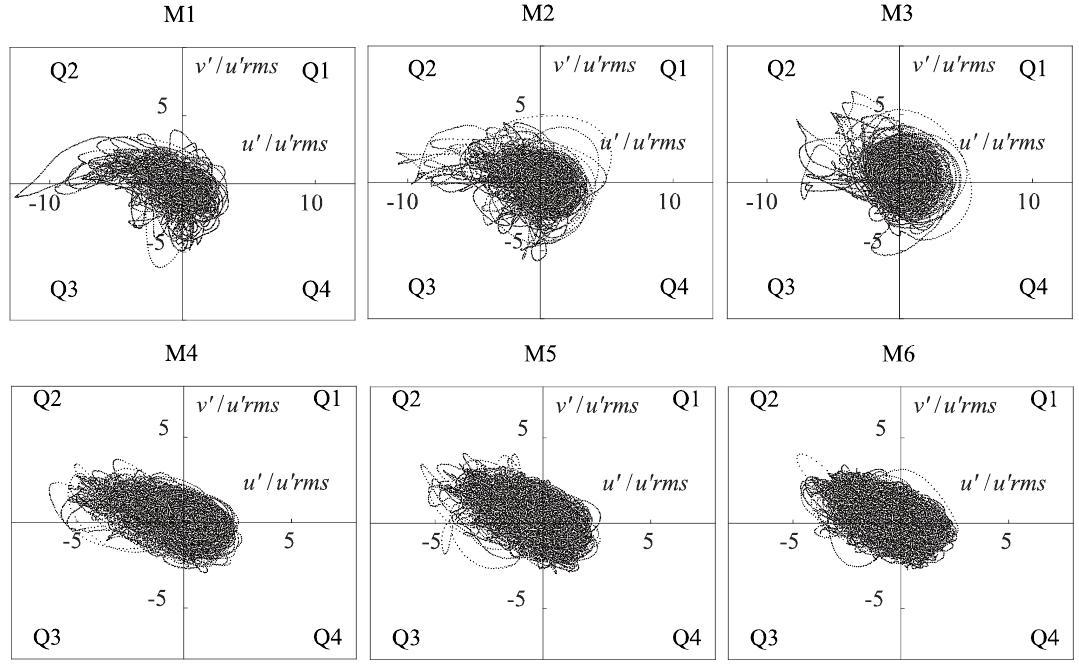
Figure 9. Quadrant analysis of the streamwise and spanwise velocity fluctuations normalized by (cid:48) rms for Case 1 at z / H = 0.51; Q1–Q4 represent the four quadrants, u’ rms for Case 1 at z / H = 0.51; Q1–Q4 represent the four quadrants, respectively. u